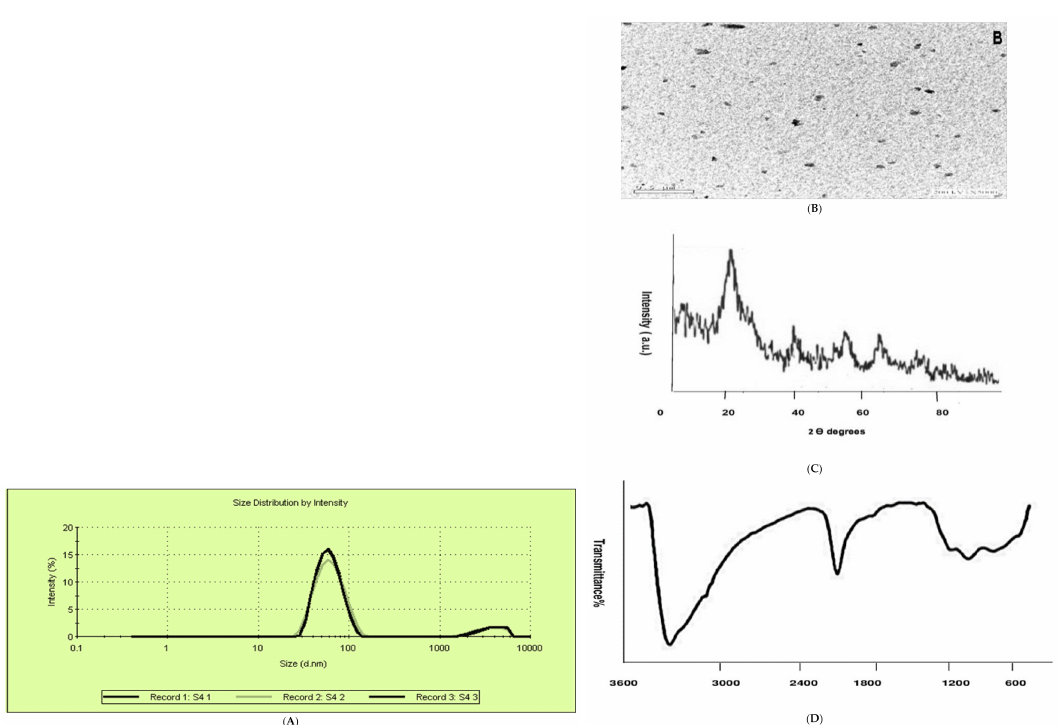
Figure 1. Characterization of titanium dioxide nanoparticles. ( A ) Dynamic light scattering (DLS). ( B ) High-resolution transmission electron microscopy. ( C ) X-ray differentiation. ( D ) Fourier transform infrared